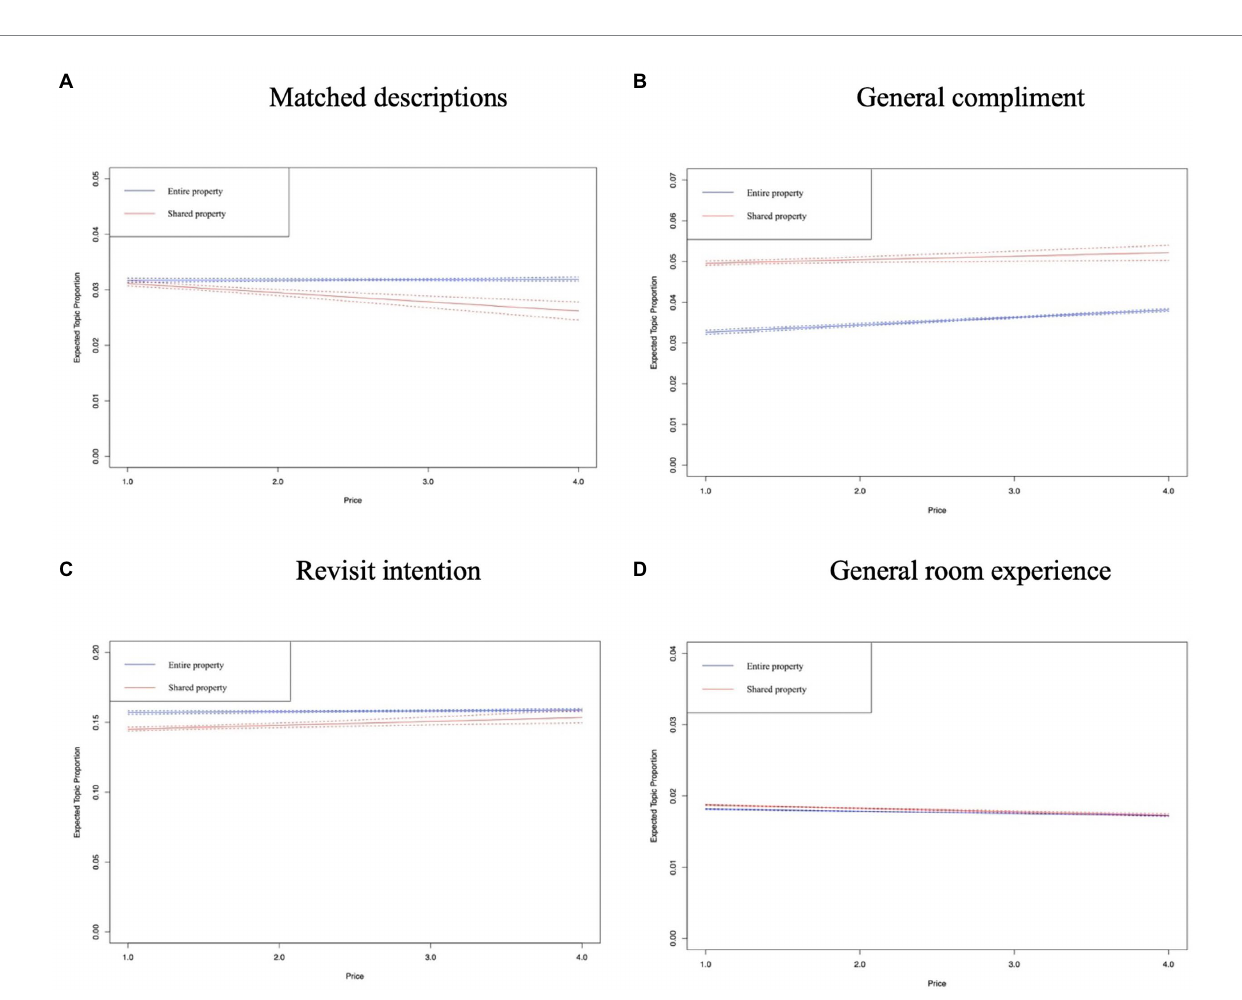
FIGURE 12 Topics in the dimension of general experience. (A) Matched descriptions. (B) General compliment. (C) Revisit intention. (D) General room